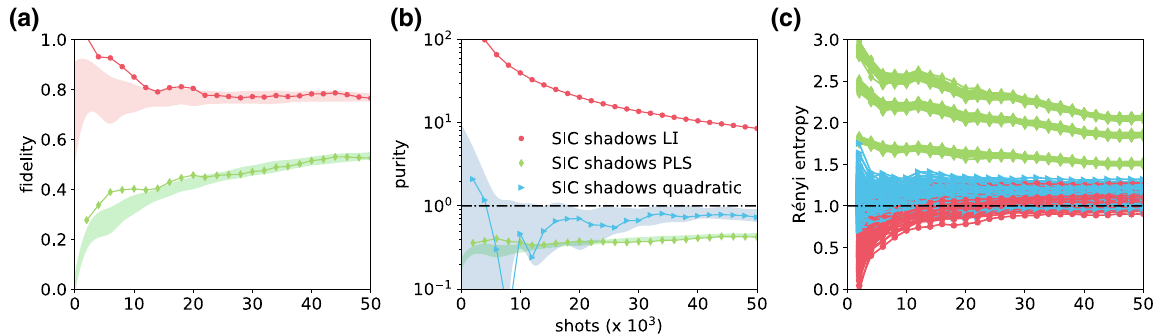
FIG. 8. Detailed postprocessing analysis of the rotated eight-qubit GHZ state from Fig. 5 in the main text. Results now cover all bipartitions, which is not feasible in real time on a desktop computer. Shaded regions represent 1 standard deviation around the mean value when averaging over multiple sets of a total of 12 500 s of data. (a) We find fidelity from LI to converge before 20 000 shots, i.e., 500 s of data taking. (b) Classical shadow purity as converges well by 40 000 shots, or about 1000 s of data taking, which in the postprocessing analysis here is also confirmed by the saturation of the standard deviation towards more shots. The remaining fluctuations arise from systematic drifts in the experiment over the course of the measurements. (c) SIC-based classical shadows converge even quicker than the time it takes to measure just one shot per Pauli basis. On the other hand, LI and PLS are significantly slower, with PLS even showing a distinct separation between the individual bipartitions [ ( 1, 7 ) qubits, ( 2, 6 ) qubits, ( 3, 5 ) qubits, ( 4, 4 ) qubits]. Dash-dot horizontal lines denote ideal